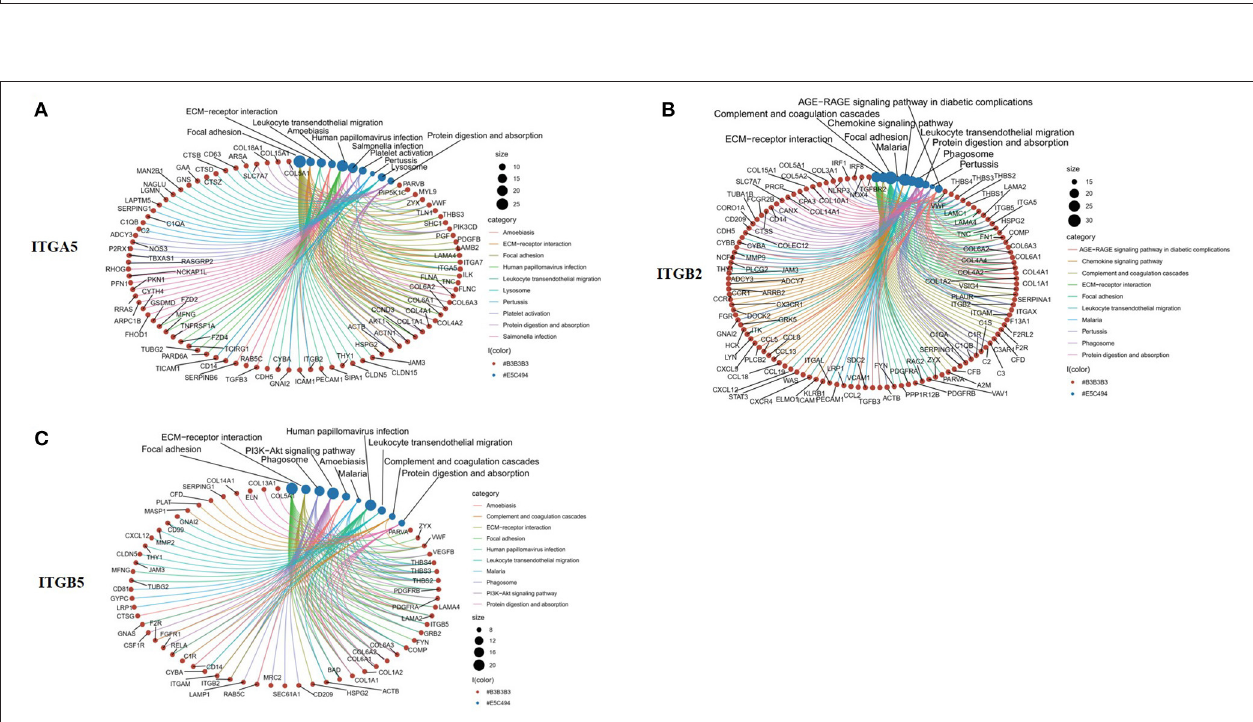
Frontiers in Medicine | www.frontiersin.org